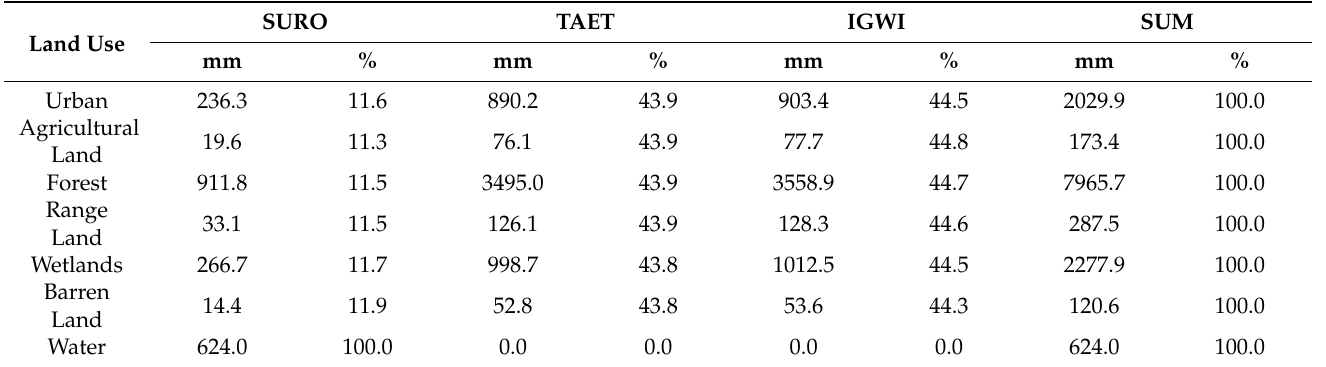
Table 7. Hydrologic components for each land use from Scenario 2.